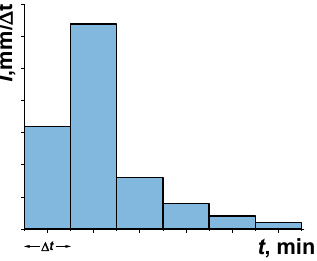
Figure 2. Diagram of Euler type II model precipitation [12].